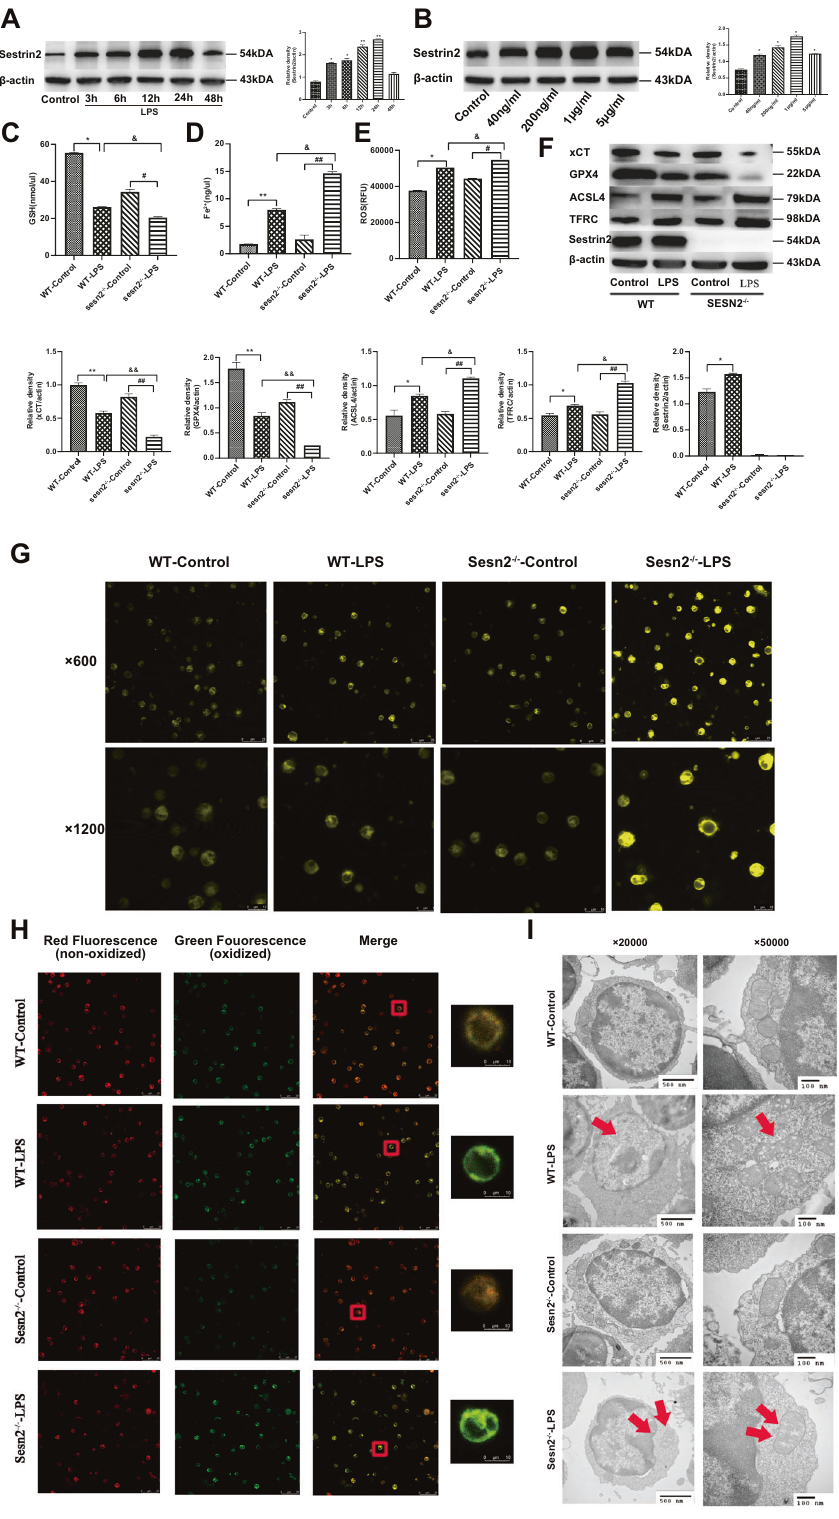
groups, tended to exhibit increased IFN- γ levels and IFN- γ /IL-4 ratios, as well as CD4 + T-cell proliferation, and these differences were marked in the CLP + Lip-1 group. Proliferation of DCs on T cells in the Sesn2 − / − -CLP + Lip-1 group was obviously lower than that in the WT-CLP + Lip-1 group (Fig. 6F – H, P < 0.05 or P <